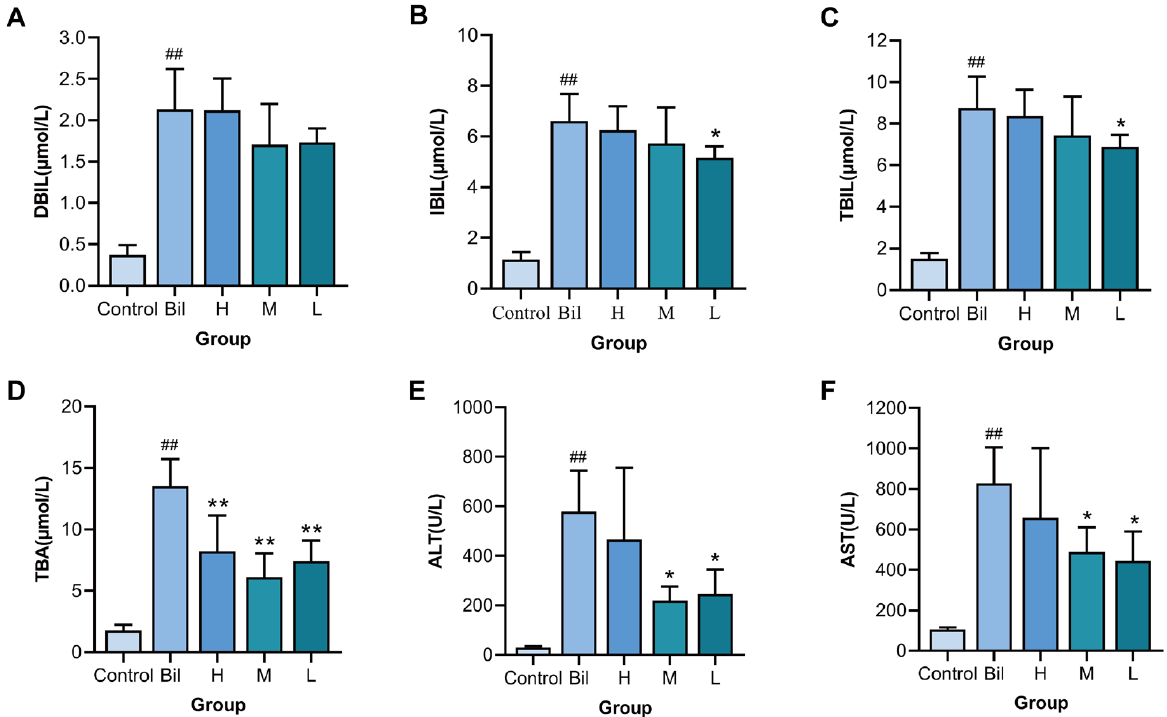
Figure 6. Effects of PGC-CDs on biochemical levels in serum of mice with hyperbilirubinemia model. ( A ) Direct bilirubin (DBIL); ( B ) Indirect bilirubin (IBIL); ( C ) Total bilirubin (TBIL); ( D )Total bile acid (TBA); I Alanine aminotransferase (ALT); ( F ) Aspartate aminotransferase (AST). They were divided into control group (Control), Bil group (Bil), and high (H), medium (M) and low (L) dose PGC-CDs groups (5.80, 2.90 and 1.45 mg/kg), n = 6. Compared with the control group, ## p < 0.01. Compared with the Bil group, ** p < 0.01, * p < 0.05.